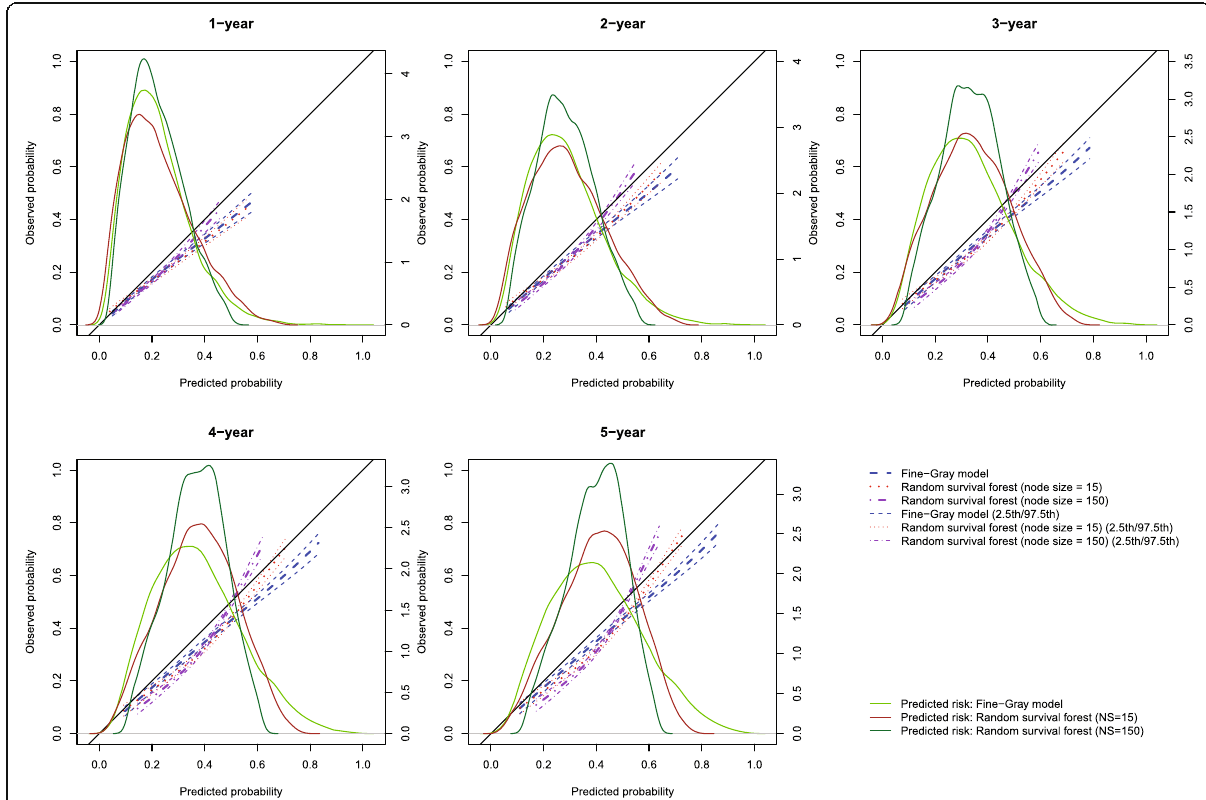
Fig. 13 Calibration plots (predicting cardiovascular death) for Fine-Gray model and random survival forests for case